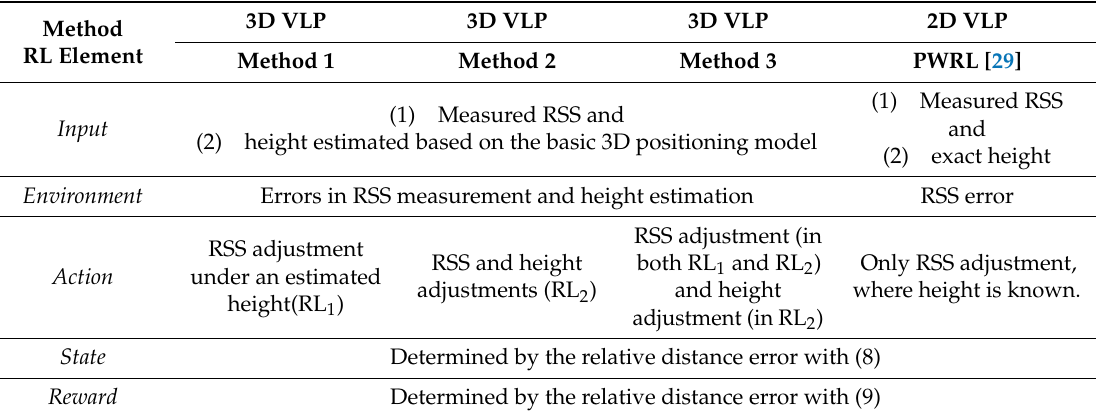
Table 1. Summary of di ff erent RL-based VLP